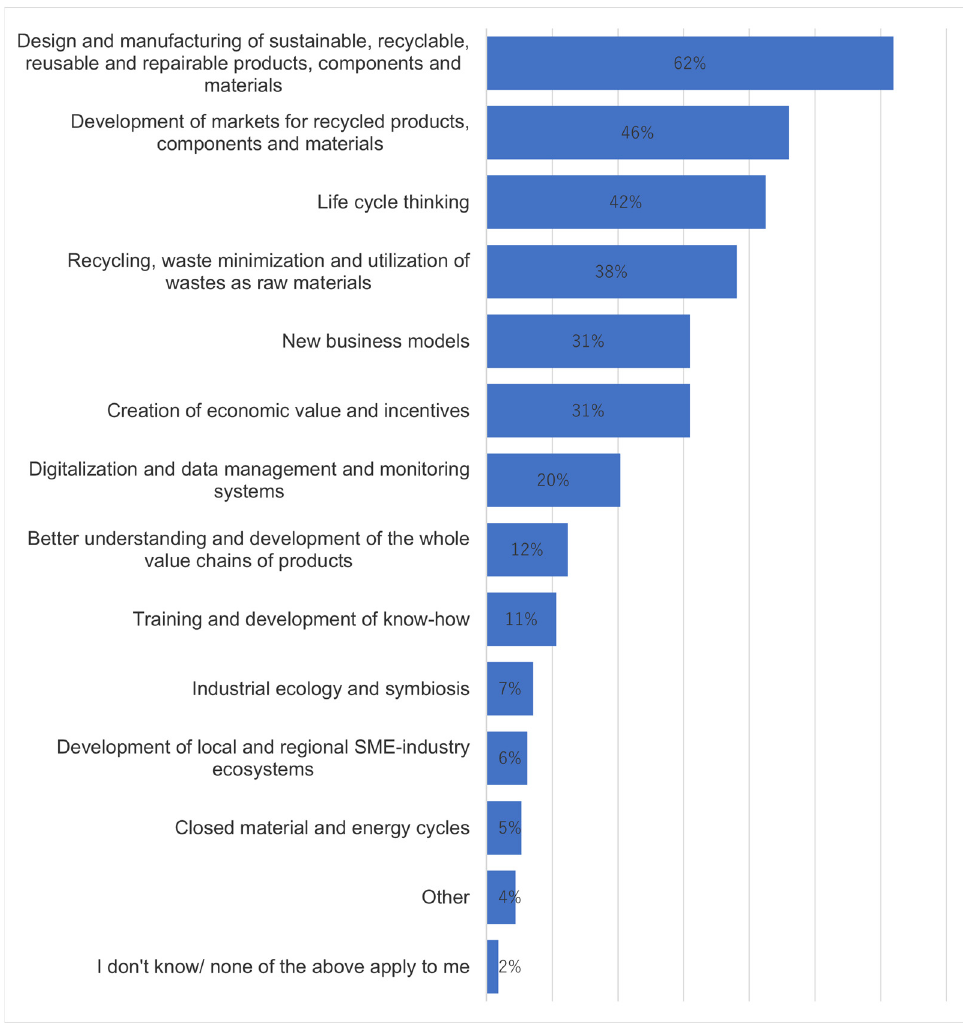
Figure 9. The best ways to create and maintain value in a circular economy.